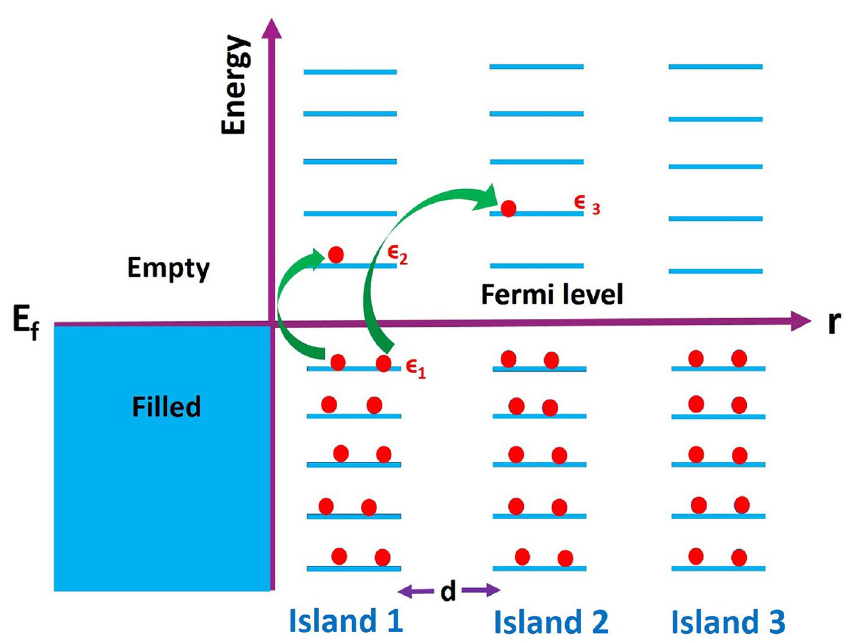
Figure 9. Schematic of Mott’s variable range hopping mechanism in nanoisland films of palladium that is a bulk metal. Two hopping events are shown by curved lines. The first hopping event is between two states 𝜖 1 and 𝜖 2 of the same island 1. The second hopping event is from